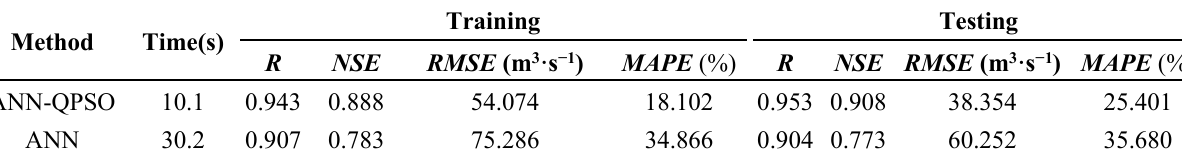
Table 3. Performance indices of two methods for Hongjiadu reservoir.